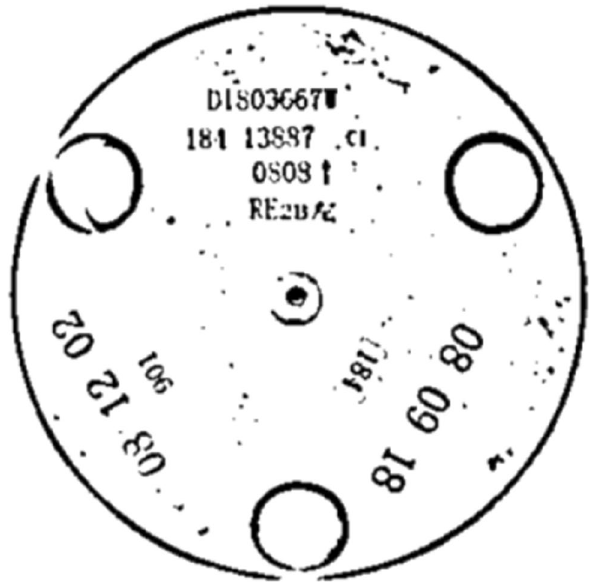
Fig. 13 Adaptive threshold segmentation